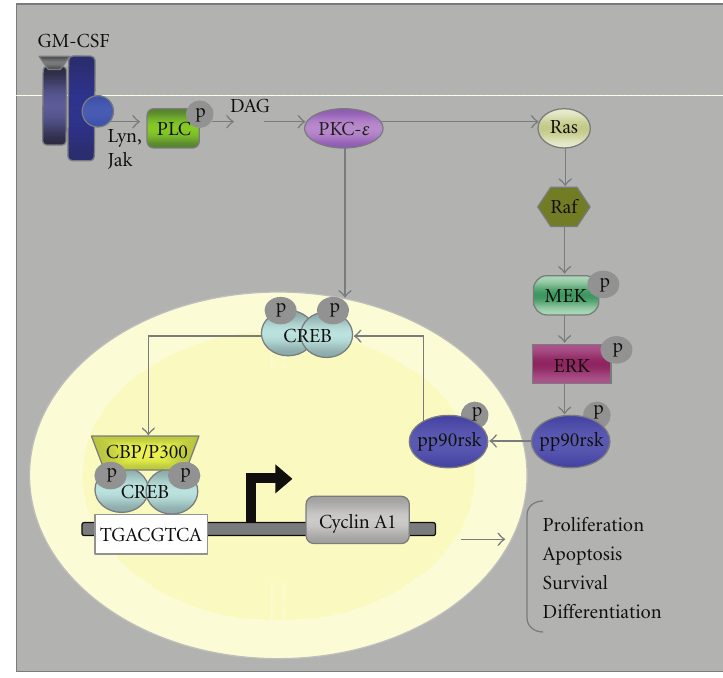
Figure 1: Pathways for CREB activation in hematopoietic cells . A variety of extracellular stimuli promote CREB activation through phosphorylation or through interaction with CREB coactivators to enhance the expression of CREB responsive genes. CREB target genes have been shown to mediate e ff ects on cellular proliferation, apoptosis, survival, and di ff erentiation. PLC : phospholipase-C, DAG : 1,2- diacylglycerol, PKC- ε : protein kinase C- ε